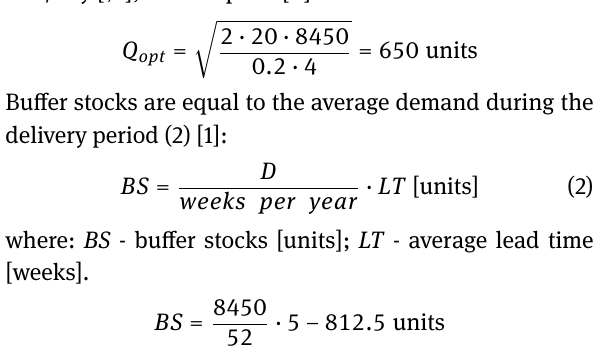
Figure 3: P-System for the inventory management [11]. Where: L- delivery time, P-order cycle, Q -order quantity, T-order point n